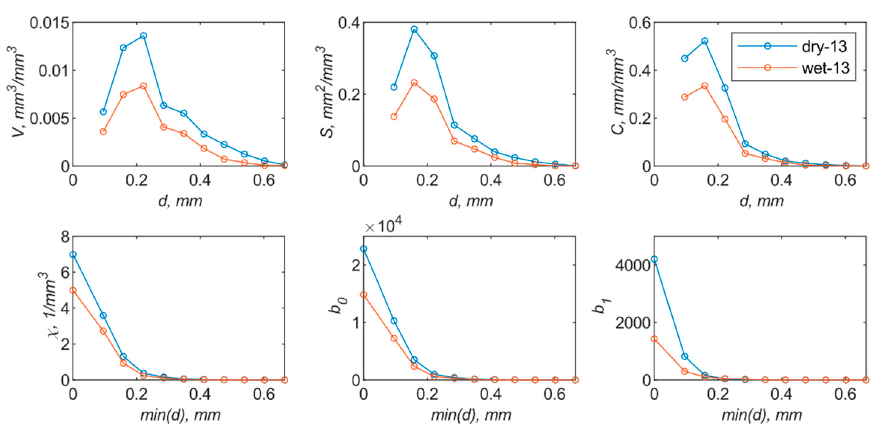
Figure 5. Distribution of pore characteristics as a function of pore sizes for a sample from horizon B2 at a depth of 80–90 cm in a dry condition (blue color) and wet condition (red color). The values V , S , C are represented by non-cumulative pores sizes distribution, whereas χ , b 0 , b 1 values are presented versus the minimum pore diameter. The minimum pore diameter corresponds to the diameter of the spherical structural unit used for morphological opening.